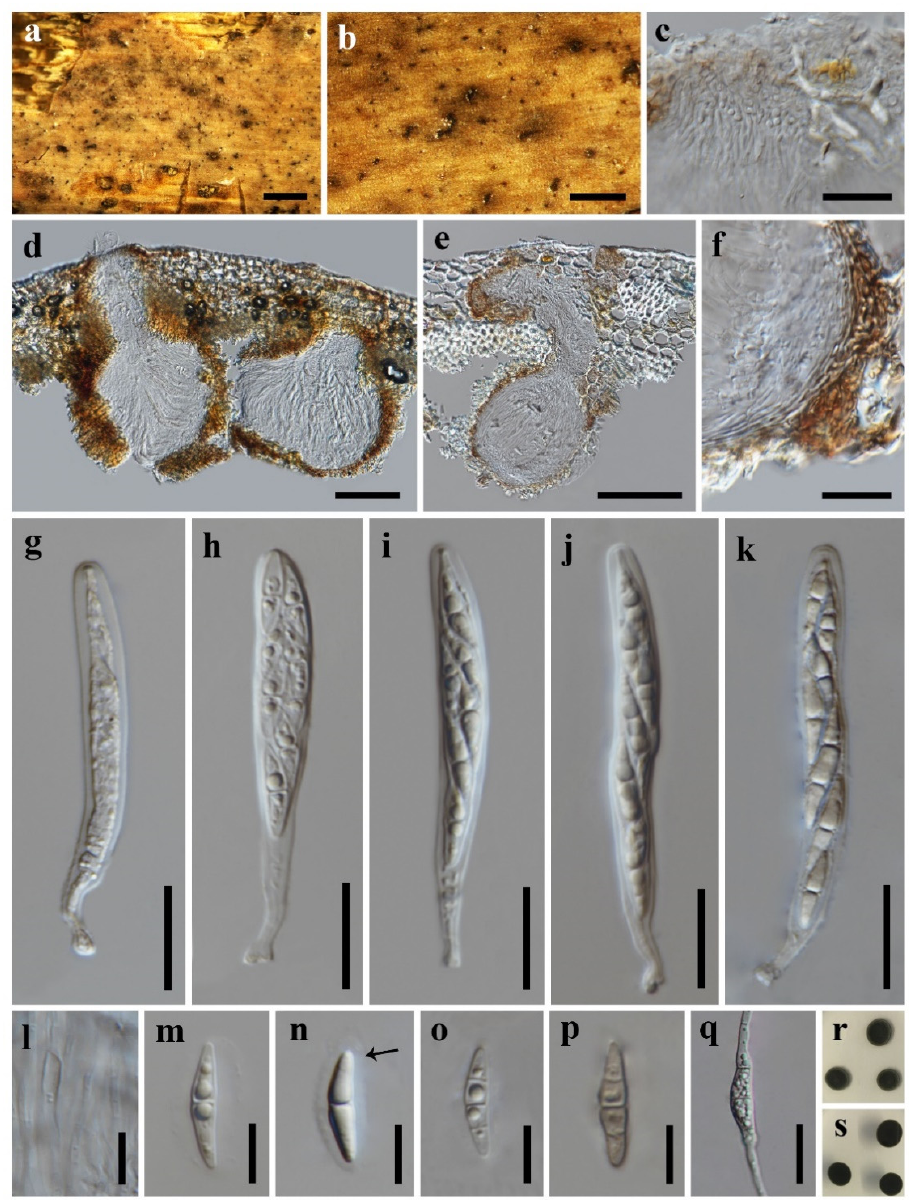
Figure 3. Neooccultibambusa kaiyangensis (HKAS 113021, holotype ) ( a , b ) Ascomata on host sub- strate. ( c ) Ostiole with periphyses ( d , e ) Vertical section of ascoma. ( f ) Structure of peridium. ( g – k ) Asci. ( l ) Pseudoparaphyses. ( m – p ) Ascospores ( n ) Arrow indicated mucilaginous sheath). ( q ) Germinated ascospore. ( r , s ) Colonies on PDA, above ( r ), reverse ( s ). Scale bars: ( a ) = 1000 µ m, ( b ) = 500 µ m, ( c , f – k , q ) = 20 µ m, ( d , e ) = 100 µ m, ( l – p ) = 10 µ